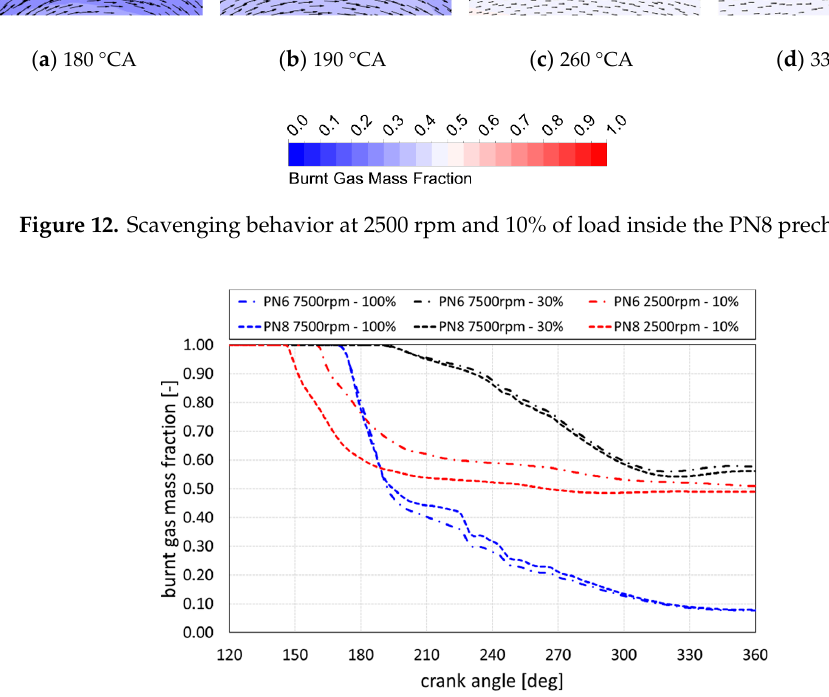
Figure 13. Differences in MFBG behavior during scavenging between the two prechambers.